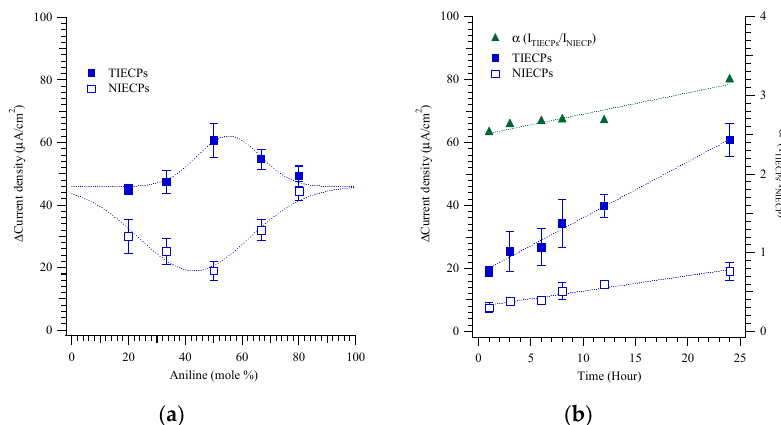
Figure 1. ( a ) Aniline concentration and changes in current density from cyclic voltammograms (CVs) in a solution of 20 mM potassium ferricyanide (K 3 [Fe(CN) 6 ]), 20 mM potassium ferrocyanide (K 4 [Fe(CN) 6 ]), and 0.5 M KCl with/without 10 pg mL − 1 of testosterone on testosterone- and non-imprinted poly(aniline- co -metanilic acid)-coated electrodes, ( b ) imprinting effectiveness and current density versus polymerization duration of testosterone-imprinted and non-imprinted poly(aniline- co -metanilic acid).